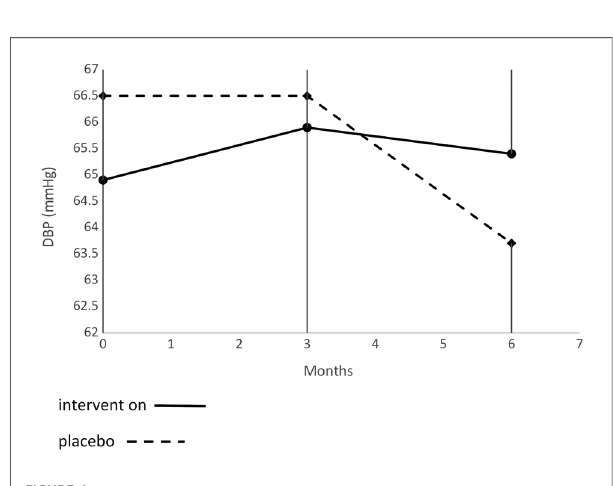
FIGURE 4 Evaluation of diastolic blood pressure throughout the study period.